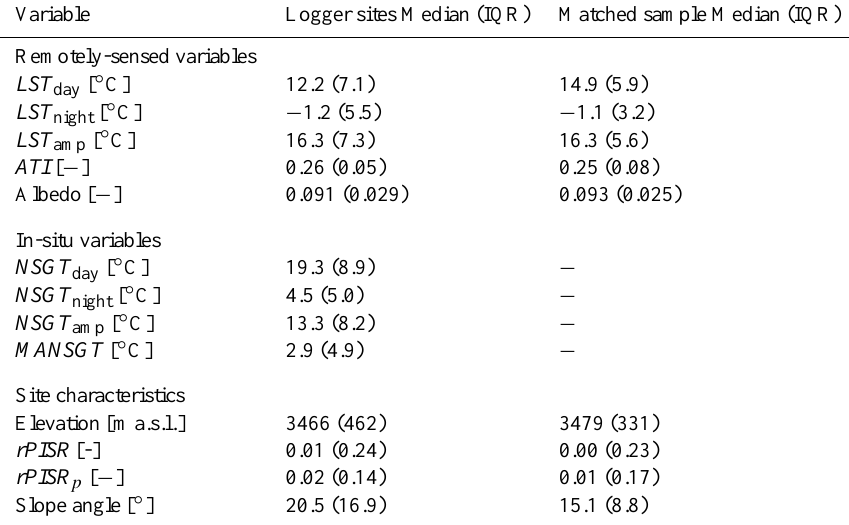
Table 2. Descriptive statistics of remotely-sensed and in-situ variables and site characteristics at the logger sites and in the matched random sample.